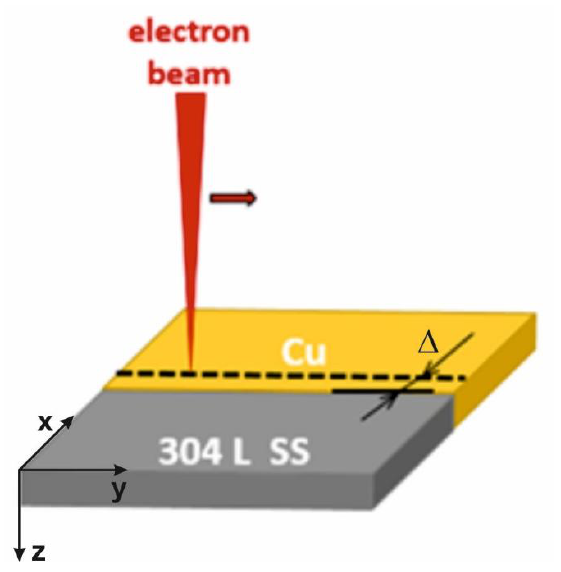
Figure 1. Scheme of the experiment of EBW of copper and AISI 304L stainless steel with beam offset toward copper side.